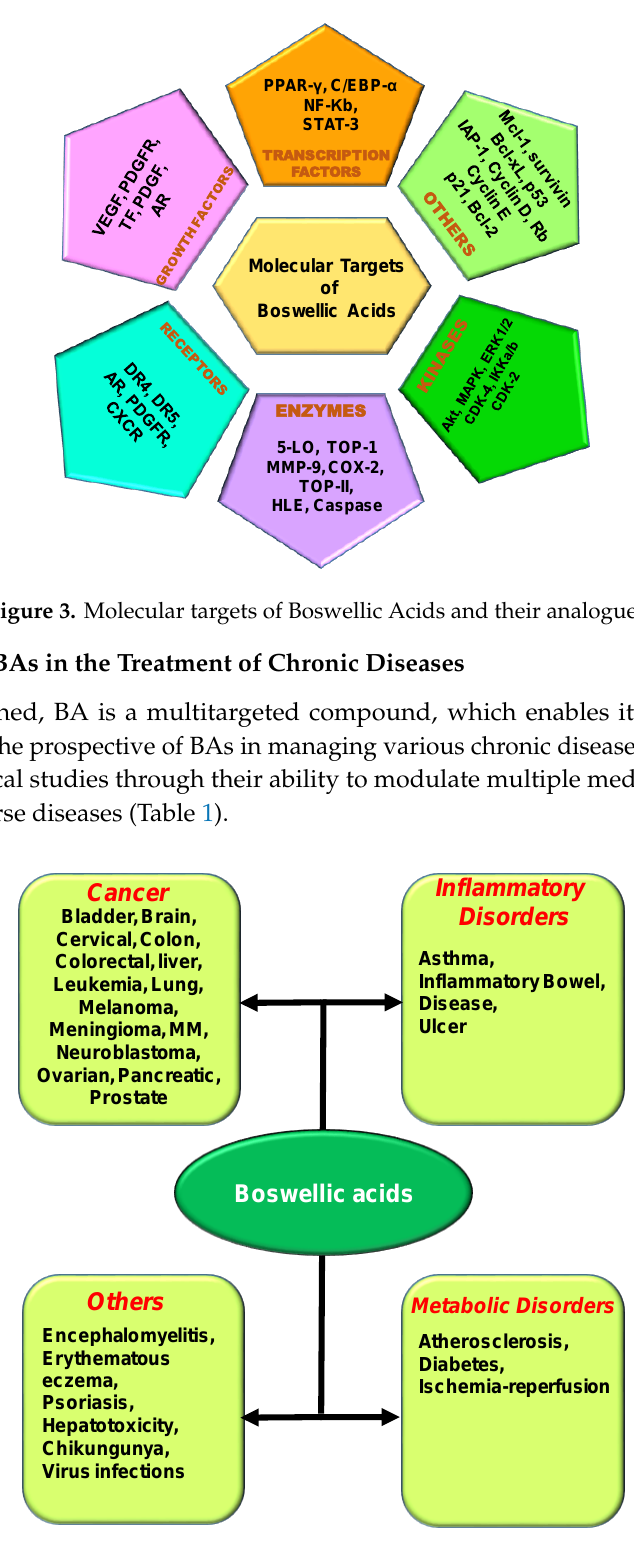
Figure 4. Biological activities of Boswellic Acids against diverse chronic diseases.